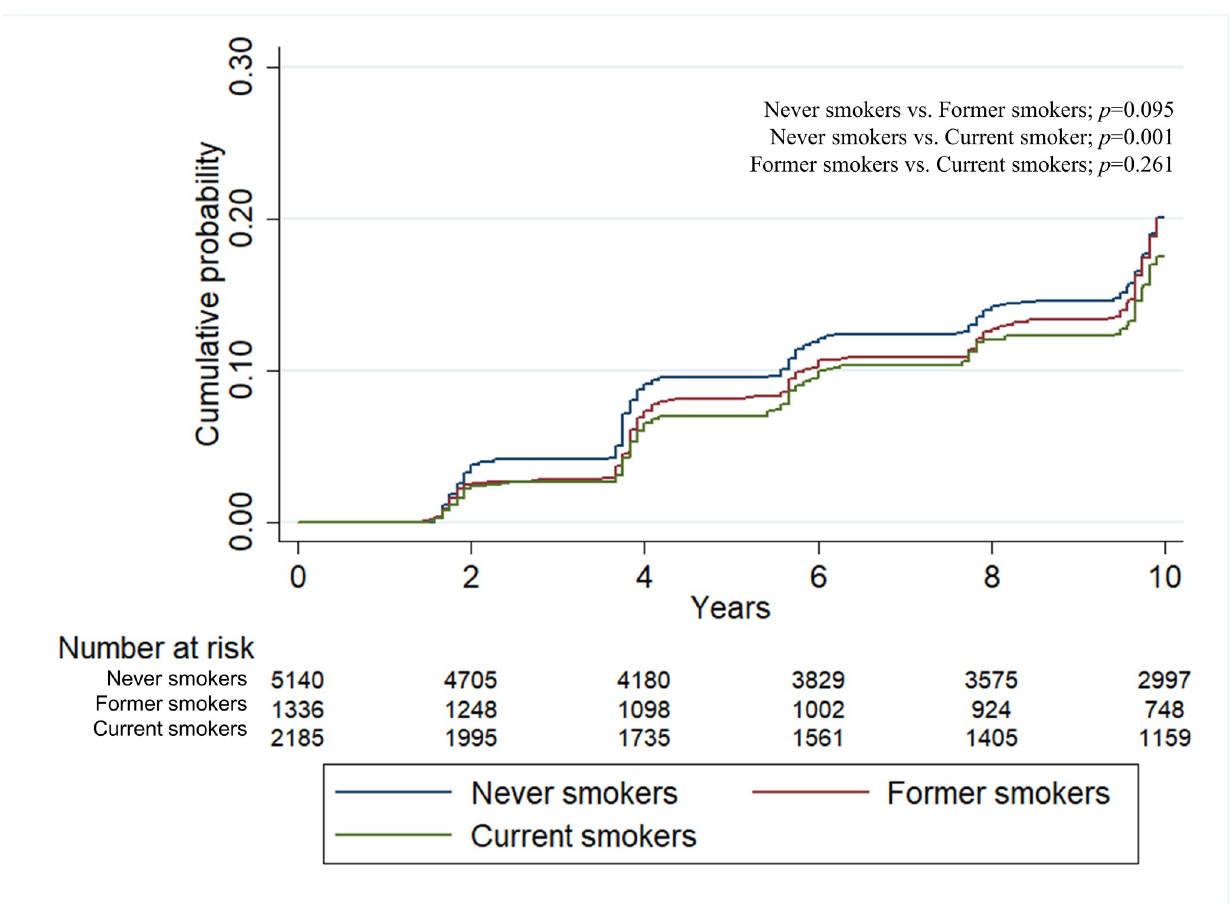
Fig 3. Kaplan-Meier curve for incident CKD.